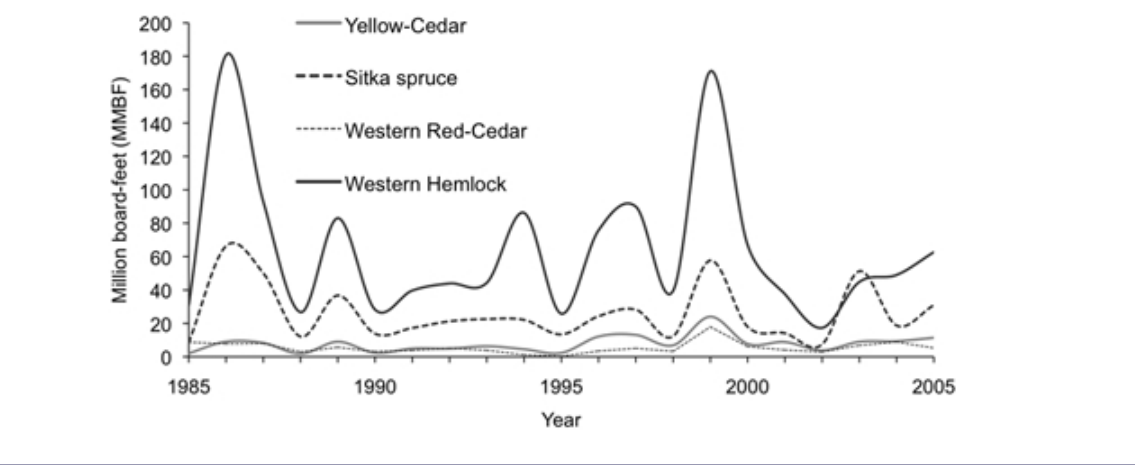
Fig. 5 . Tongass National Forest timber volume offered by species from